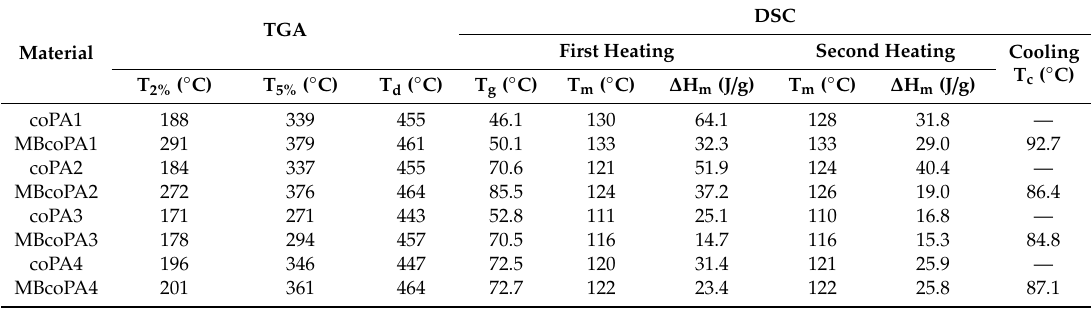
Figure 5. The example TGA curve for the neat coPA2 and its masterbatch containing 7 wt % MWCNT. Table 4. Summary of the thermal analysis results. “—” means a lack of peak on the